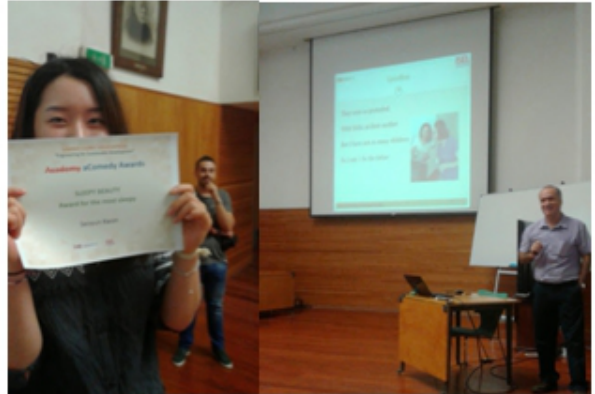
Figure 8. E4SD: Farewell session